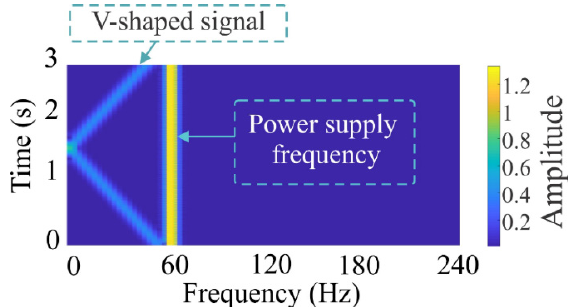
Figure 1. Time–frequency plane for an IM with a BRB condition by using the STFT and Equation (1) with a fsupply = 60 Hz and a time window of 3